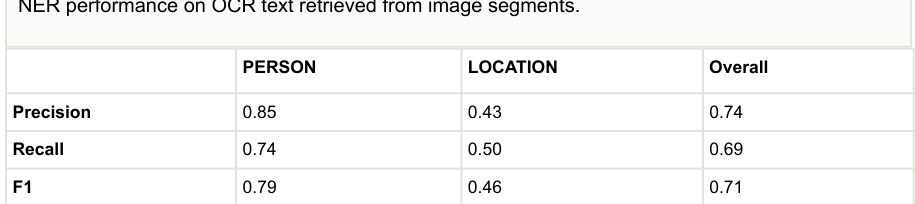
NER performance on OCR text retrieved from image